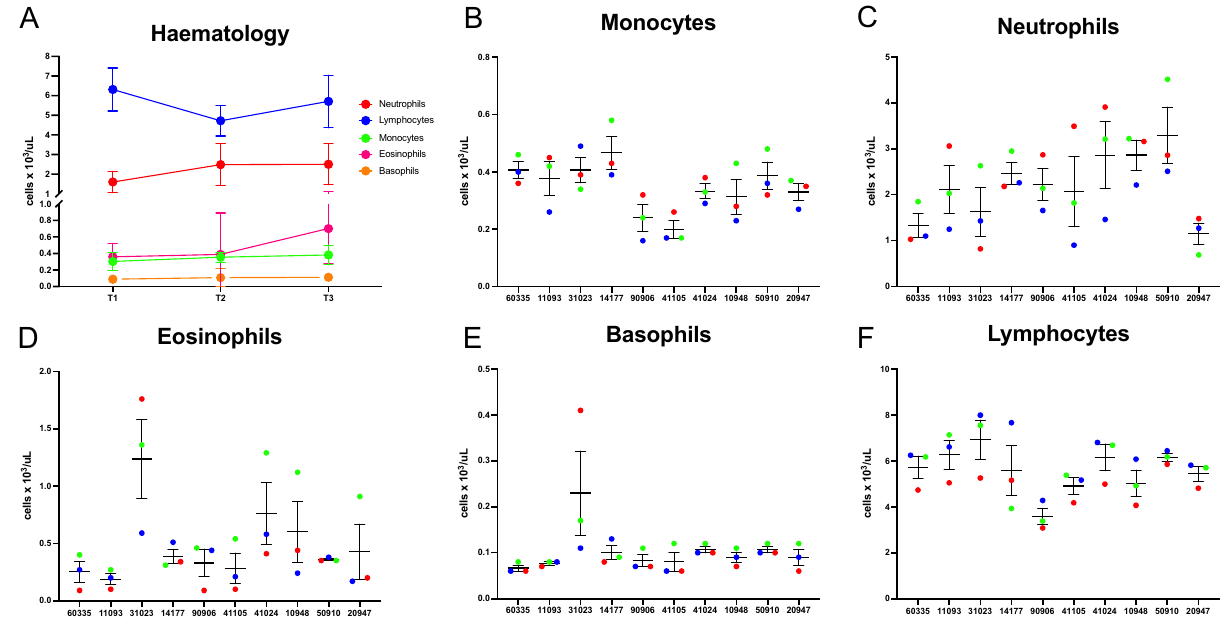
Figure 2. Absolute cell counts for monocytes, neutrophils, eosinophils, basophils and lymphocytes, reported as cells × 10 3 /µL, using blood collected in EDTA tubes from ten cattle at three timepoints across 4 months. ( A ) Haematology data shown for the whole group of cattle (n = 10) across three time points. ( B – F ) Individual haematology data for each animal at three timepoints (blue = timepoint 1, red = timepoint 2, green = timepoint 3). Results were graphed using Prism software (v9.1) (www. graph pad.